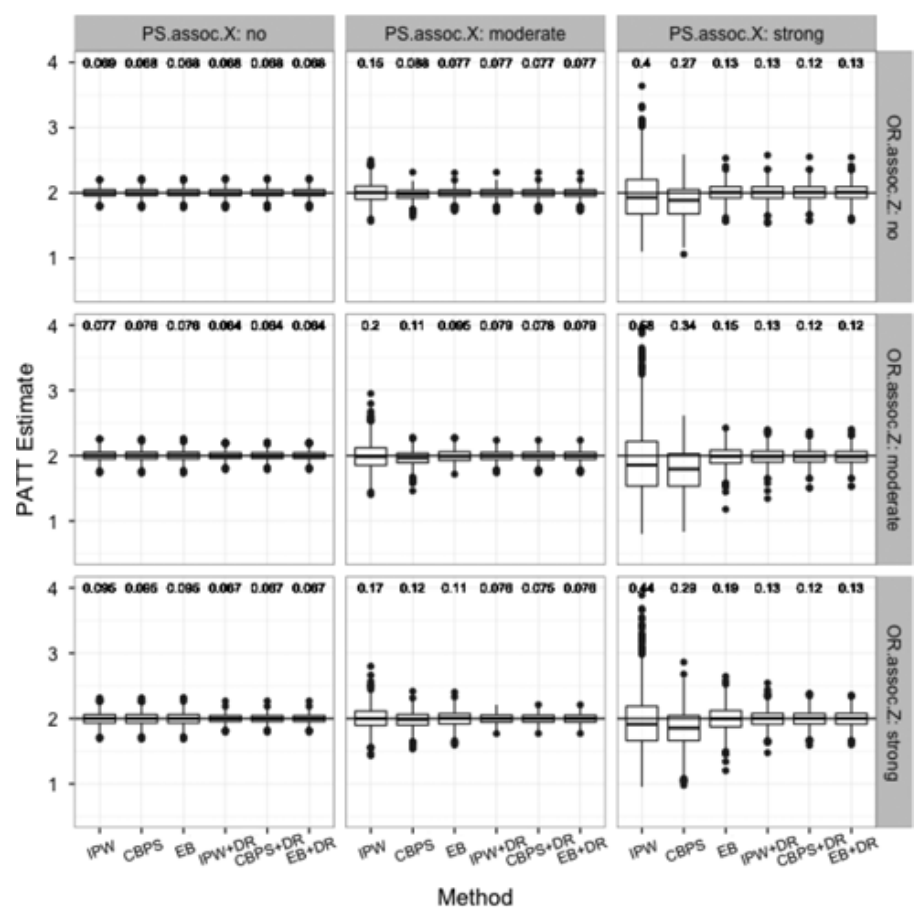
Figure 6: Results of the Lunceford-Davidian example (partial propensity score modeling). The settings are exactly the same as Figure 4 except the methods here don ’ t use Z in their propensity score